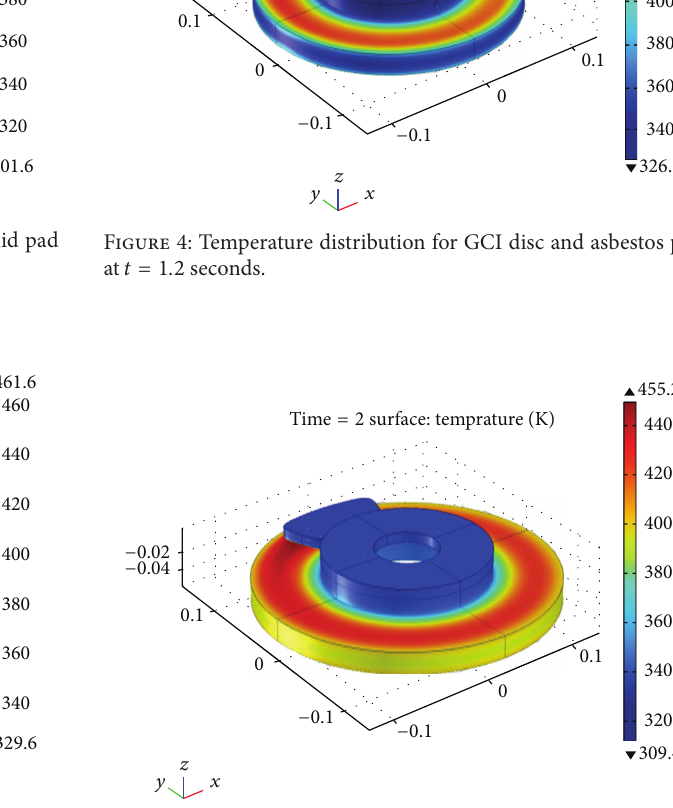
Figure 5: Temperature distribtion for AMC disc and aramid pad at 𝑡 = 2 seconds.